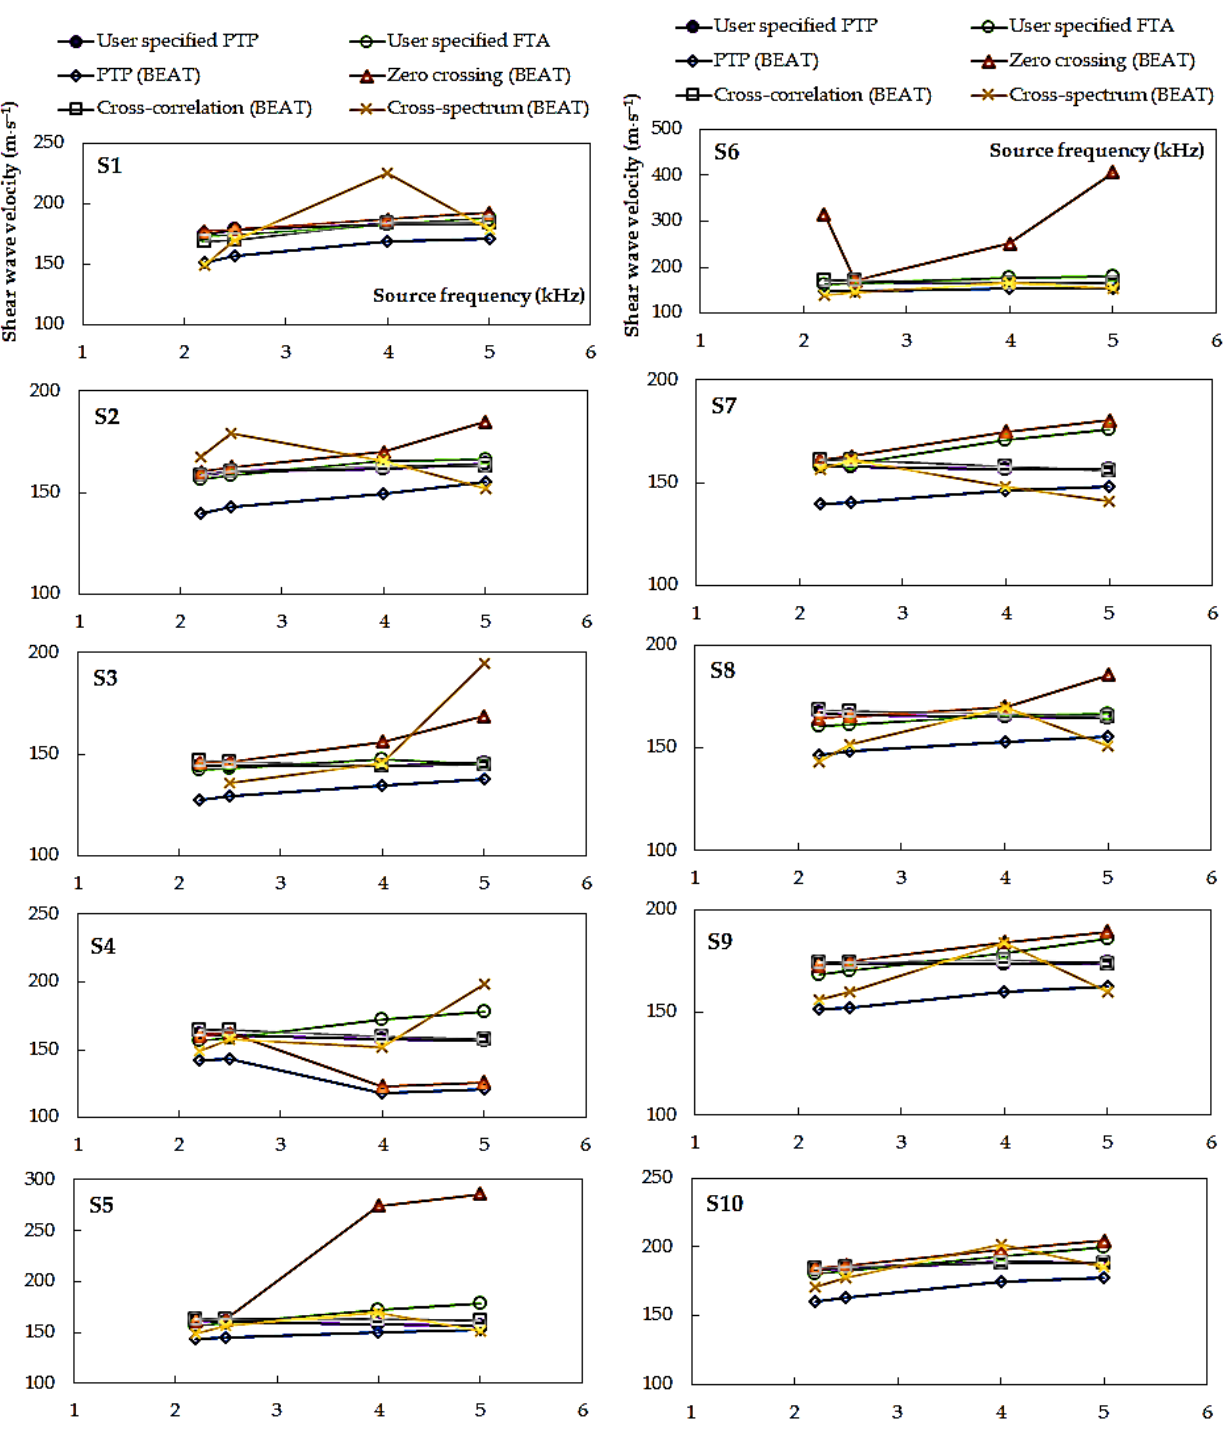
Figure 9. Shear wave velocities calculated from various methods of interpretation of BE test results, data for specimens S1–S10.